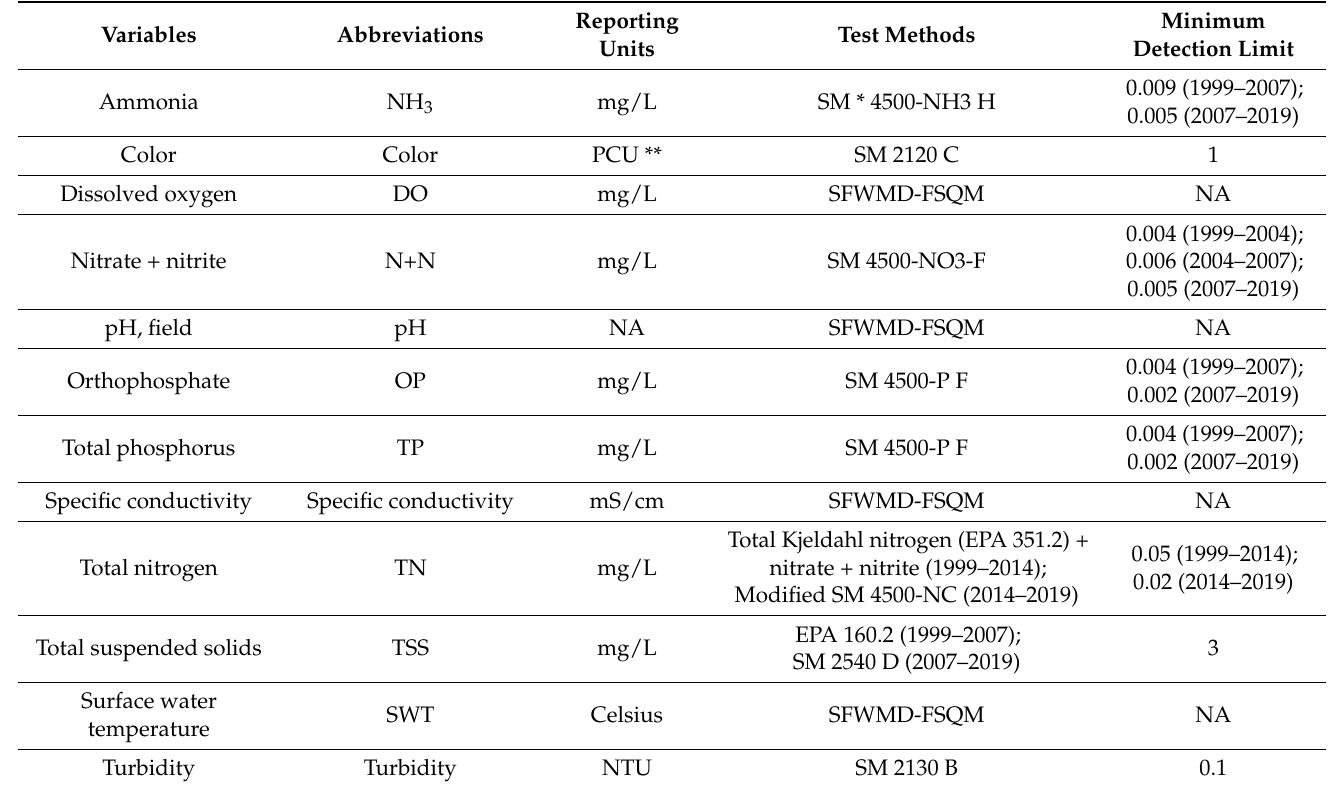
Table 2. Water quality variables. Abbreviations are those used in this paper and not by the management agency. Test methods are the methods used by the chemistry laboratory to obtain the values for each